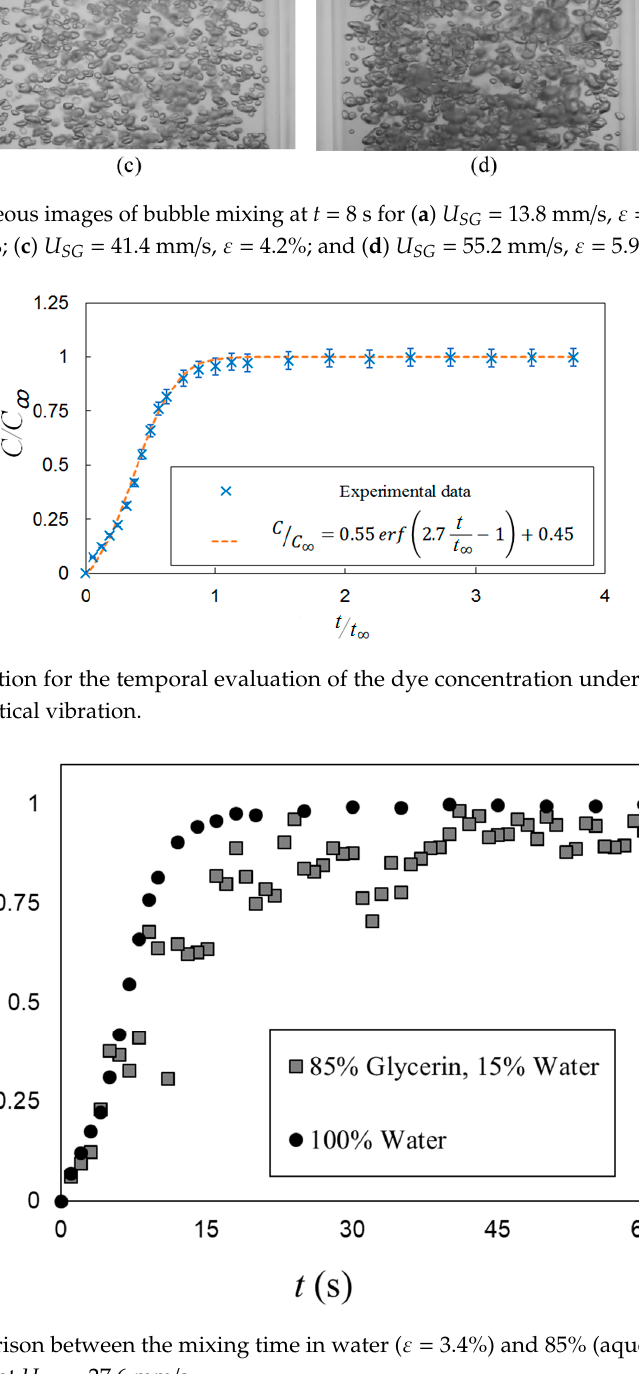
Figure 9. A comparison between the mixing time in water ( ε = 3.4%) and 85% (aqueous) solution of glycerin ( ε = 4.4%) at U SG = 27.6